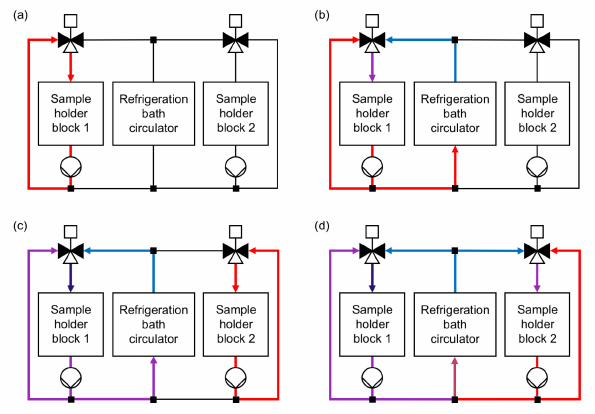
Figure 2. Cooling system layout and operating principle of the Twin-plate Ice Nucleation Assay (TINA). (a) Cooling liquid is pumped in warm cooling loop of sample holder block 1 without connection to colder cooling liquid provided by refrigeration bath circulator. (b) Mixing valve is opened for both warm cooling liq- uid of warm cooling loop and cold cooling liquid of refrigeration bath circulator. Position of mixing valve defines temperature within sample holder block 1. (c) Sample holder block 1 is cooled further down, while cooling liquid is pumped in warm cooling loop of sam- ple holder block 2. (d) Sample holder block 2 can be run in parallel independently of the temperature in sample holder block 1.